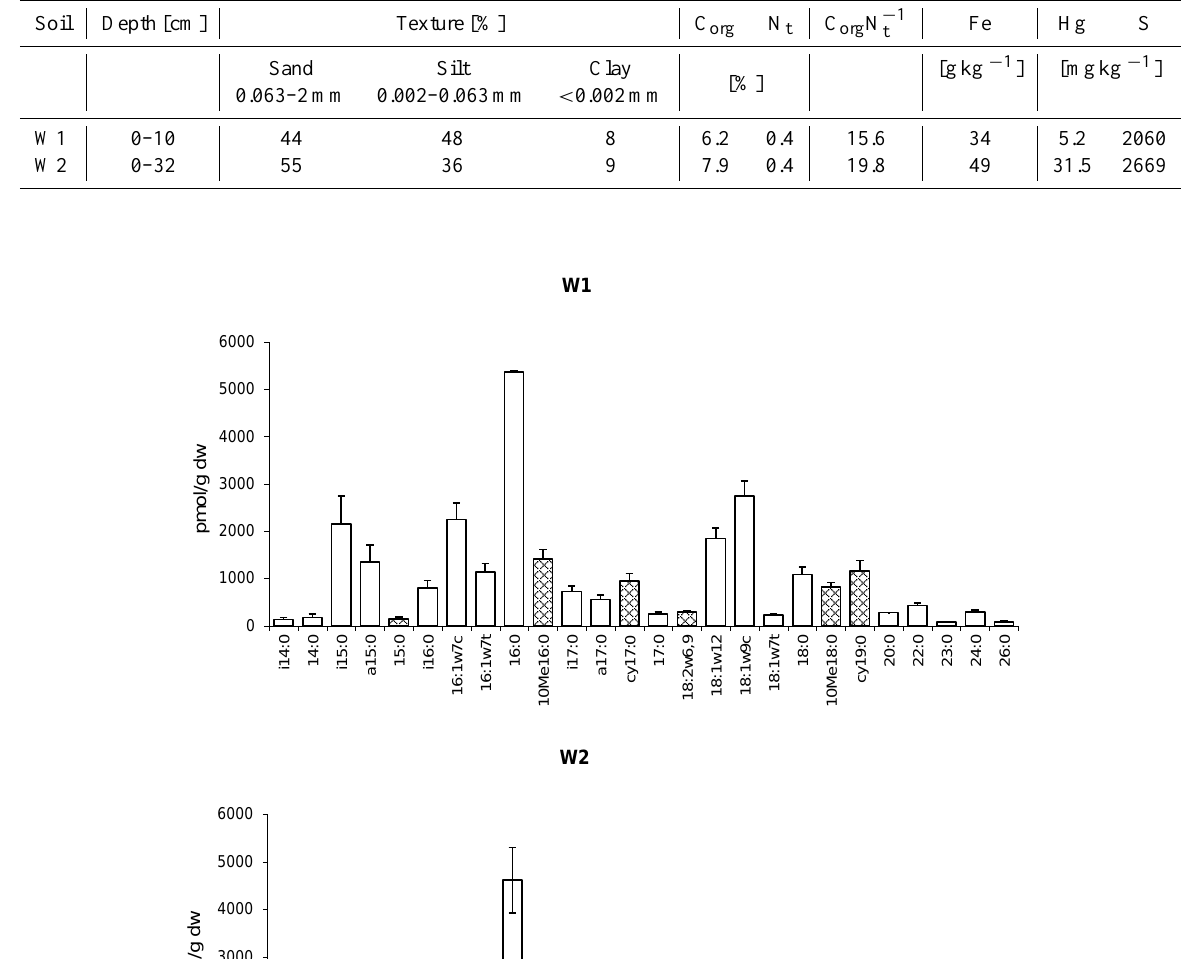
Table 1. Selected properties of the studied soils (C org : organic carbon, N t : total nitrogen) total metal concentrations (aqua regia soluble), and total sulfur (S) of the studied bulk soils Wupper 1 (W1) and Wupper 2 (W2).